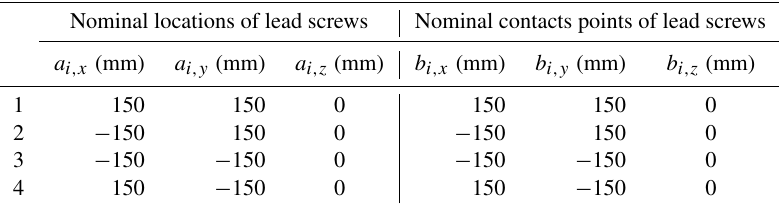
Table 1. Nominal parameters for the L/R mechanism. Nominal locations of lead screws Nominal contacts points of lead screws